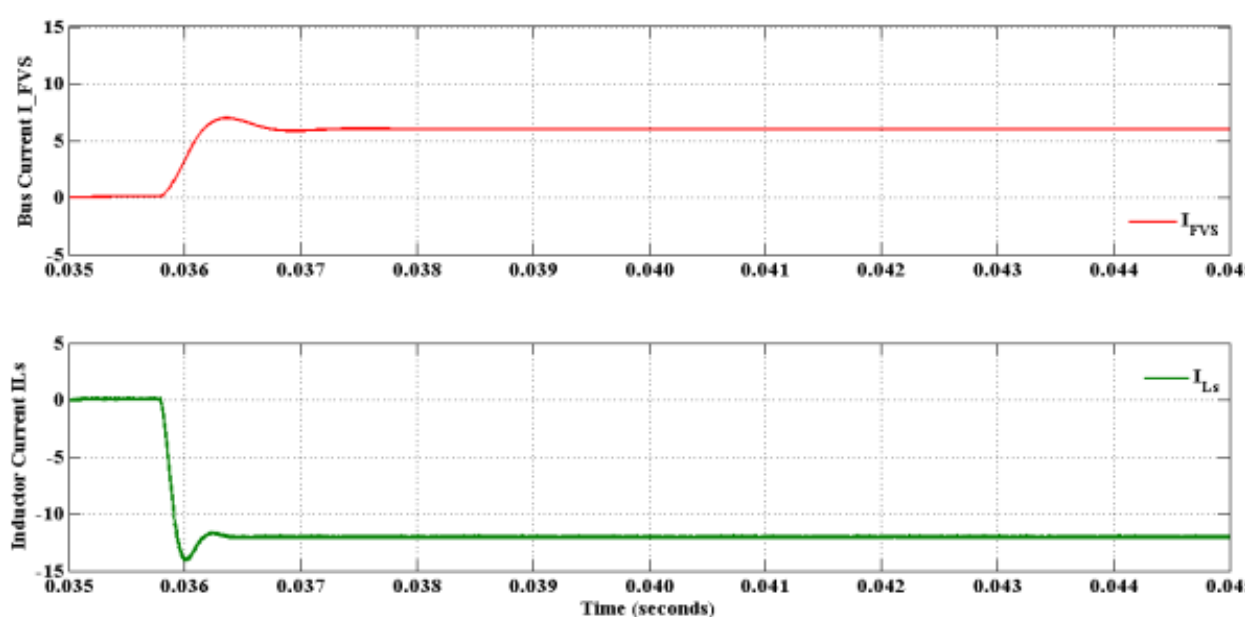
Figure 21. Regulated current step variations in inductor currents in boost mode. Comparison of PI and ANN Controller Output Waveforms Figure 22 shows a comparison of output voltage in power sharing mode at low volt- age, while Figure 23 illustrates a comparison of output voltage in DC-bus high-voltage regenerative mode. Figures 24 and 25 show controlled current step variation in inductor currents in buck and boost modes of operation.